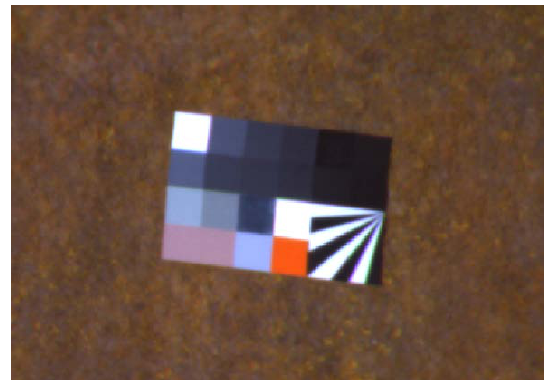
Figure 8. Part of the NIR, NIR, R band composition of PIQuAT image